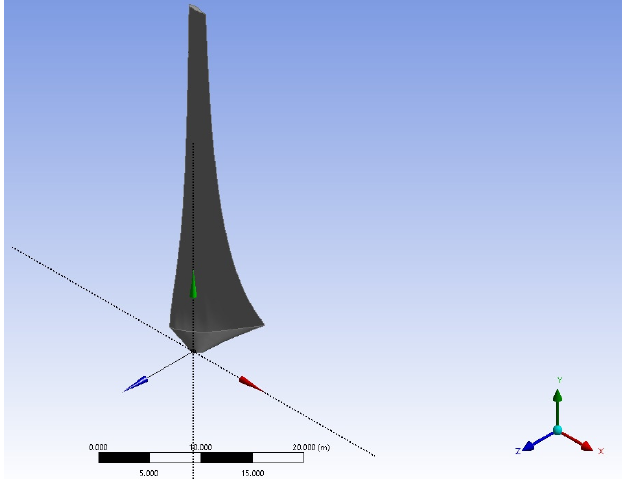
Figure 2. Detail of the optimum blade. Table 3. Computational domain dimensions, mesh size and estimated power output.